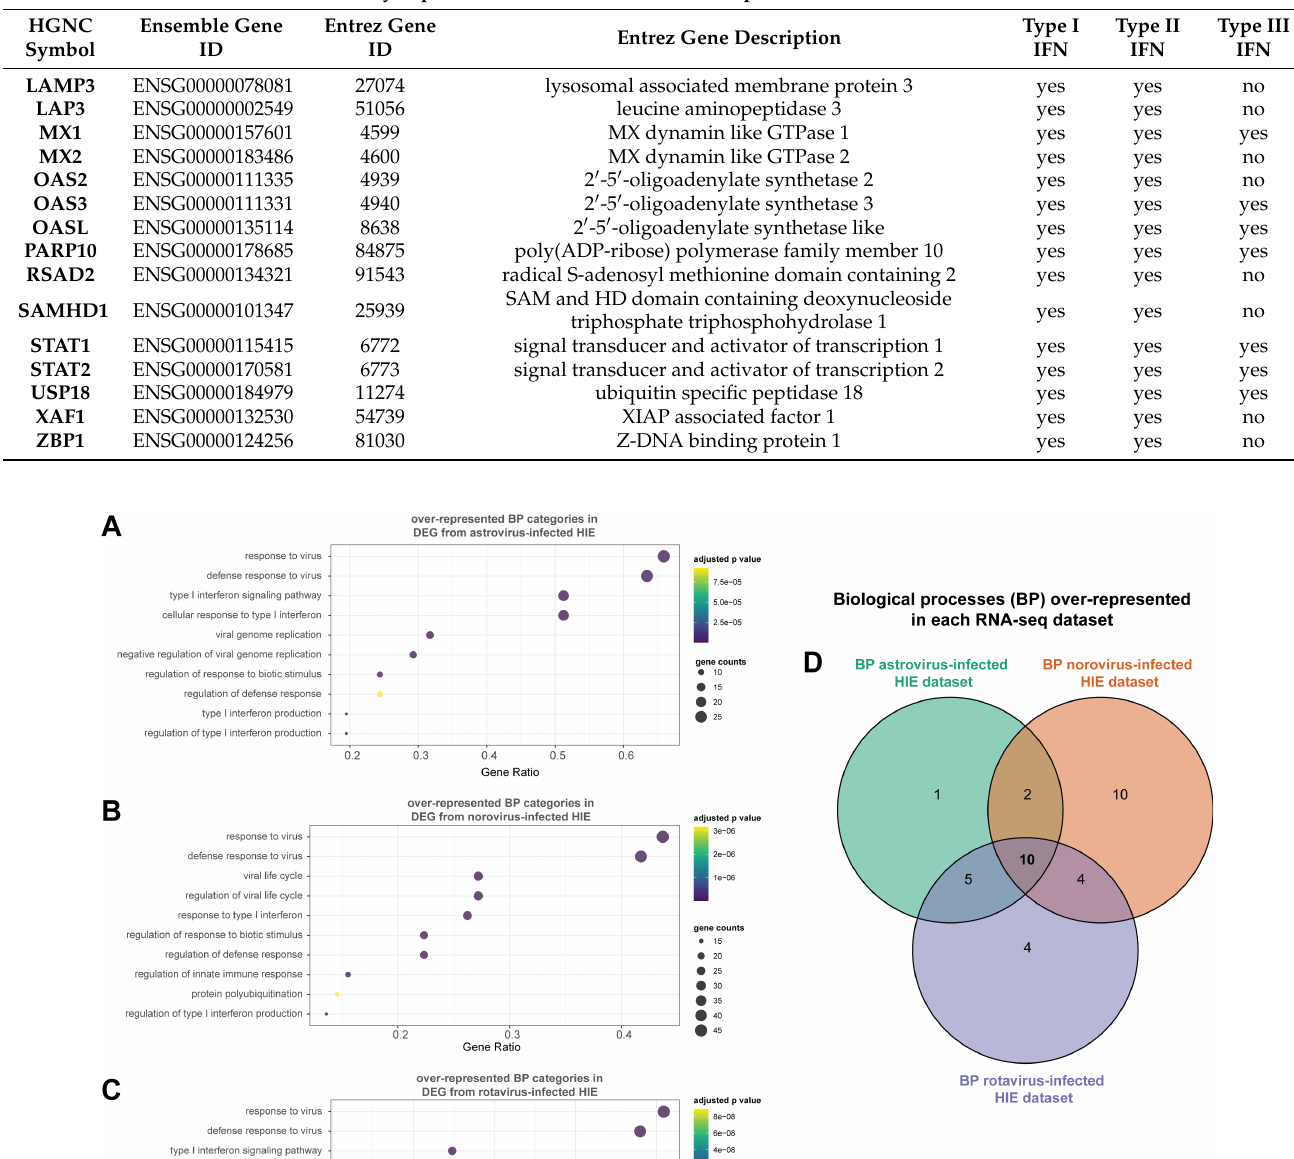
23 Overall, a shared set of DEGs informing a shared set of biological processes (BP) were identified in the three RNA-seq datasets. This conserved, predominant response of the